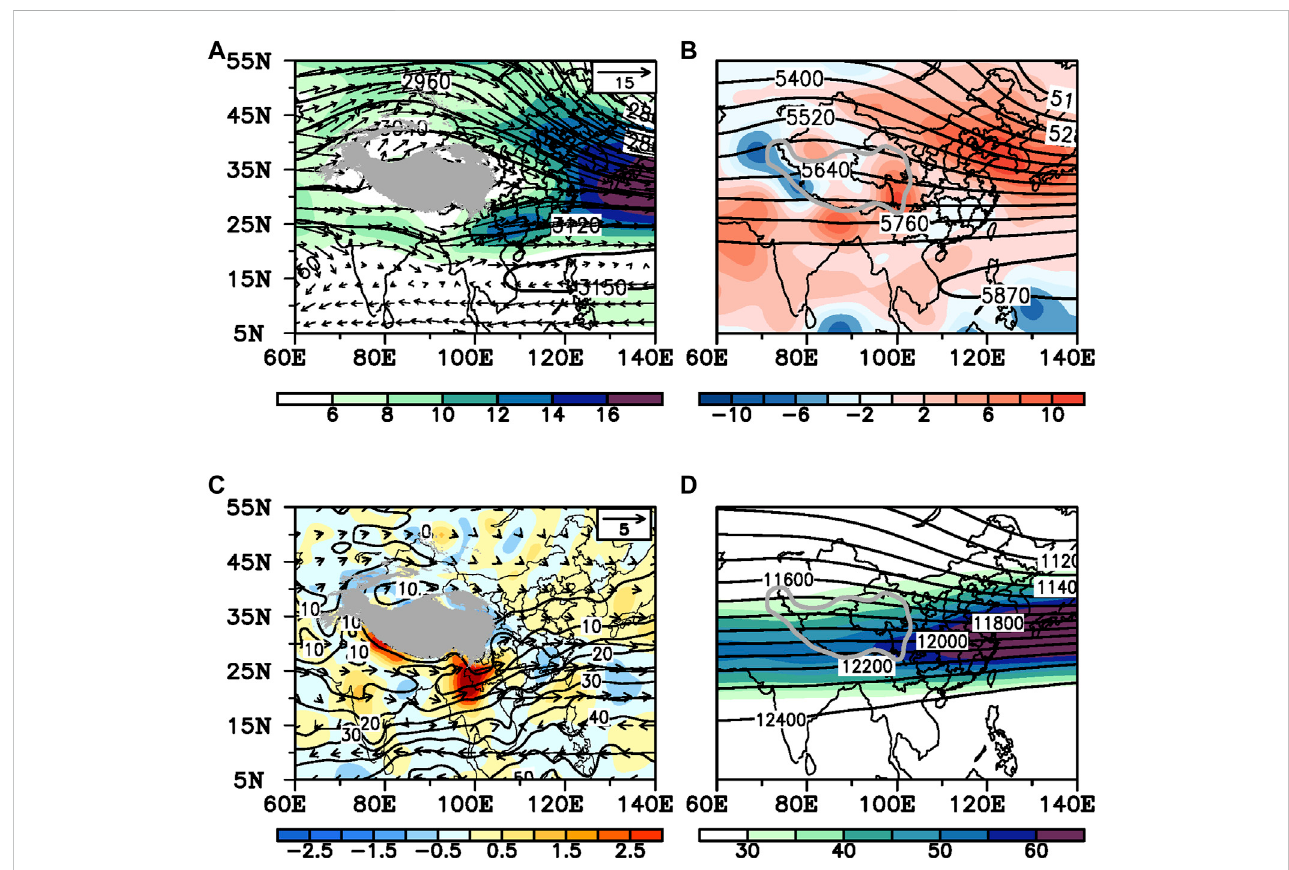
FIGURE 4 ClimatologyinJanuaryforthetimeperiod1985 – 2015. (A) Geopotentialheight fi eld(contours;units:gpm),wind fi eld(vectors;units:ms − 1 )andhorizonal wind speed (shading; units: m s − 1 ) at 700 hPa. (B) Geopotential height fi eld (contours; units: gpm) and omega fi eld (shading, units: 10 – 2 Pa · s − 1 ) at 500 hPa. (C) Watervapor fl ux(vectors;units:kgm − 1 · s − 1 ),divergenceofthewatervapor fl ux(shading;units:10 – 6 kg · m − 2 · s − 1 )at700 hPaandtheprecipitablewater(contours; units: mm). (D) Geopotential height fi eld (contours; units: gpm) and zonal wind speed at 200 hPa. Wind speeds greater than 30 m · s − 1 are shaded with intervals of 5 m · s − 1 . The gray-shaded areas (A,C) and isolines (B,D) show the shape of the Qinghai – Tibetan